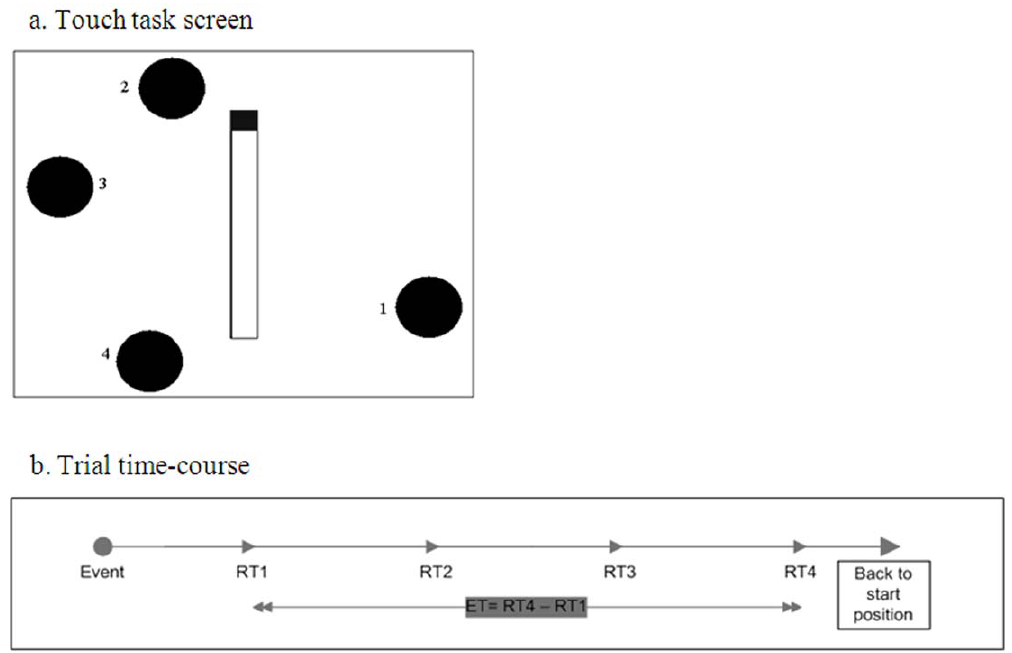
Figure 2. Task screen and time-course of a single trial. a) The relative positions of the four targets (black circles) (the numbering is for illustration purposes only and was not included in the actual display). As the targets changed color from black to yellow, the participant was instructed to turn them back to black by touching them, as fast as possible, following a predefined order (1 R 2 R 3 R 4), and to return to the starting point and wait for the next trial to begin. b) The time-course of a given trial was divided into two continuous time periods: RT1 (Reaction Time for target 1)- the time between the ‘start’ cue (the targets’ color change) and the touching of the first target. ET (Execution Time) - the time between touching the first target and touching the fourth target. touch targets were arranged in a left-right flipped manner for left- handed individuals.